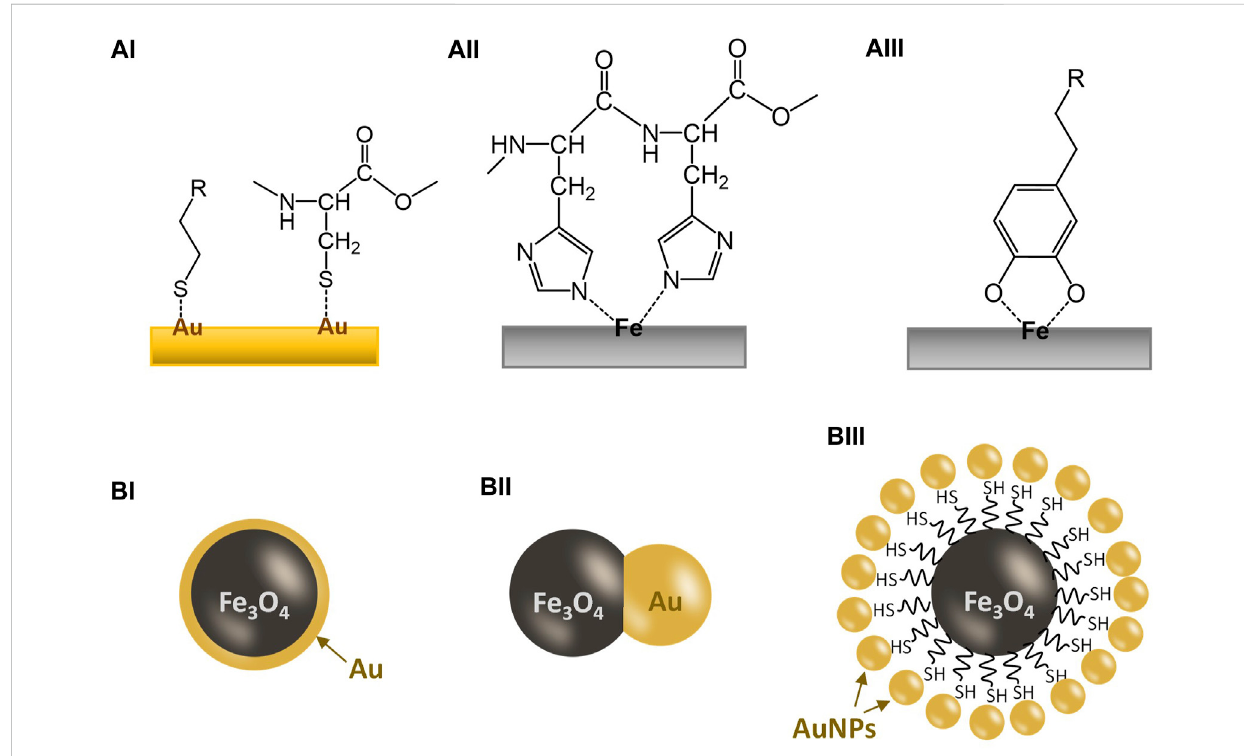
FIGURE 1 Illustration for the coordination bonding between a metal surface and a ligand and the basic designs for common Au/Fe 3 O 4 nanoparticles. (AI) Interaction between a gold surface and thiol groups; (AII) interaction between an iron surface and a dihistidine group; (AIII) interaction between an iron surface and a catechol group; (BI) a gold-coated Fe 3 O 4 nanoparticle; (BII) a Au/Fe 3 O 4 Janus nanoparticle; (BIII) a gold-dotted Fe 3 O 4 nanoparticle assembled via a thiol-functionalized